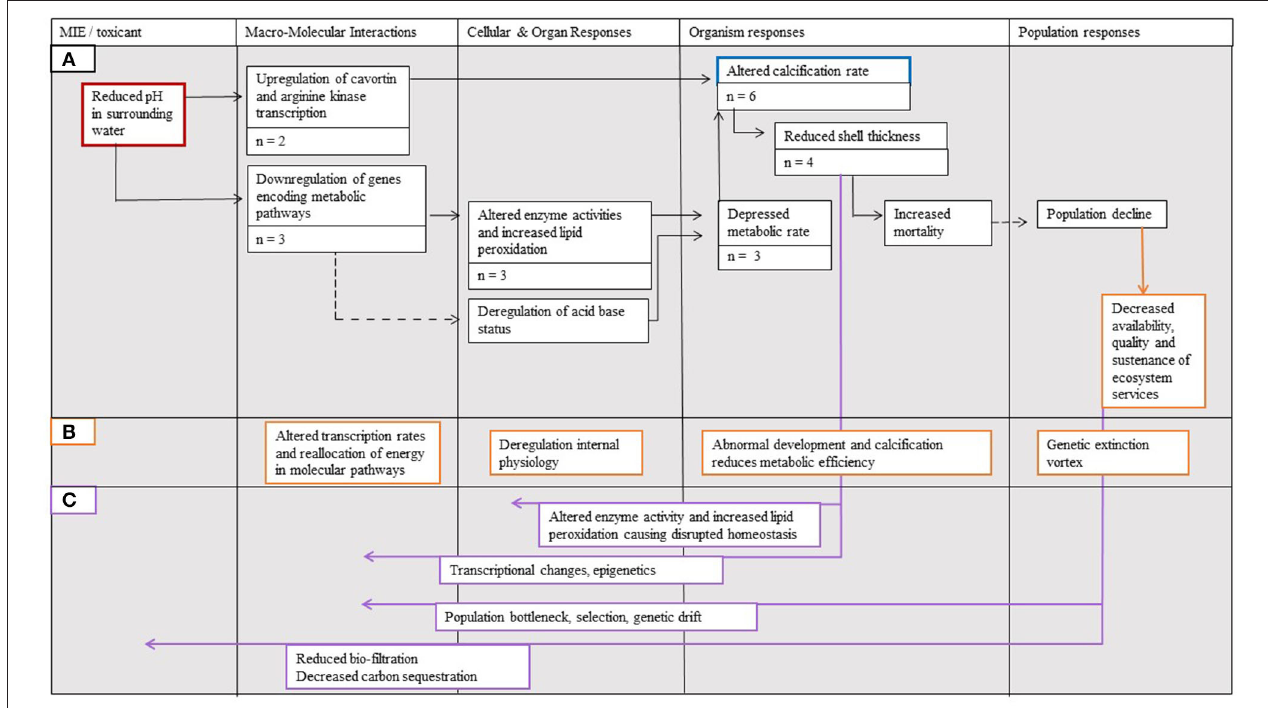
FIGURE 5 | The Adverse Outcome Pathway (AOP) linking the effects of (A) ocean acidification (red border) to calcification (blue border) and its effects on Magallana gigas , amended to incorporate (B) within-level feedback mechanisms (orange borders indicate added examples of responses and arrow lines indicate added pathways), as well as (C) interaction effects from higher to lower levels of biological organization (purple arrow lines indicate added pathways). The number of studies supporting each step is denoted n = X. Solid arrow lines represent established linkages with quantitative data documented for M. gigas , whereas dotted arrow lines represent linkages supported with data considering other